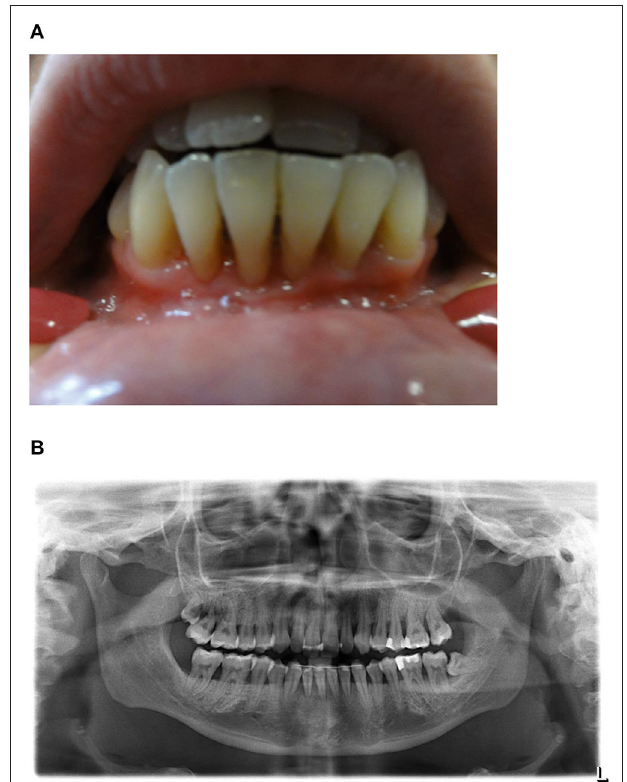
FIGURE 1 | (A) Clinical findings. Exposed root surfaces of the teeth 33–43 due to severe gingivitis and periodontitis in an age of 24 years. (B) Orthopantomogram. General alveolar bone loss caused by severe chronic periodontitis. The wisdom teeth 18 and 38 are partially erupted and the mandibular anterior teeth are stabilized by a